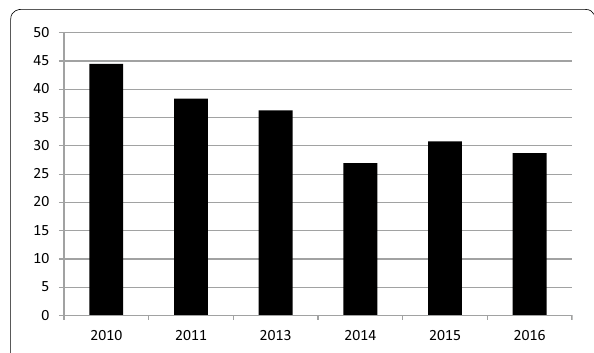
Fig. 2 Percentage of ventilated patients treated for VAP the day of the